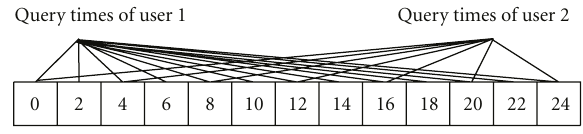
Figure 3: Example for processing redundant data.